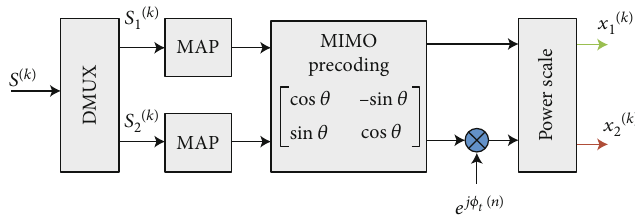
Figure 2: Dual-polarized antenna MIMO